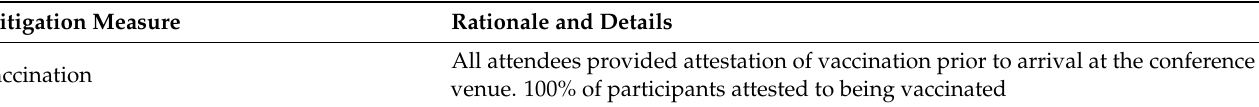
Table 1. Summary of COVID-19 safety measures at Hep-DART 2021.